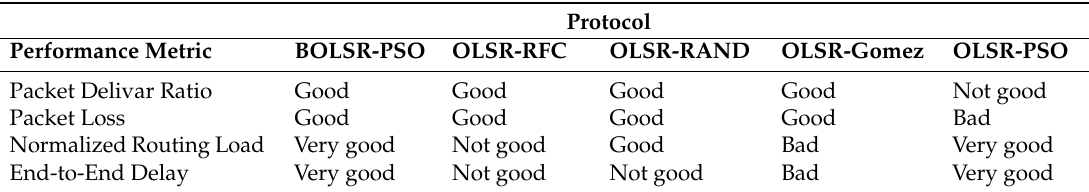
Table 9. Routing Performance and Experimental